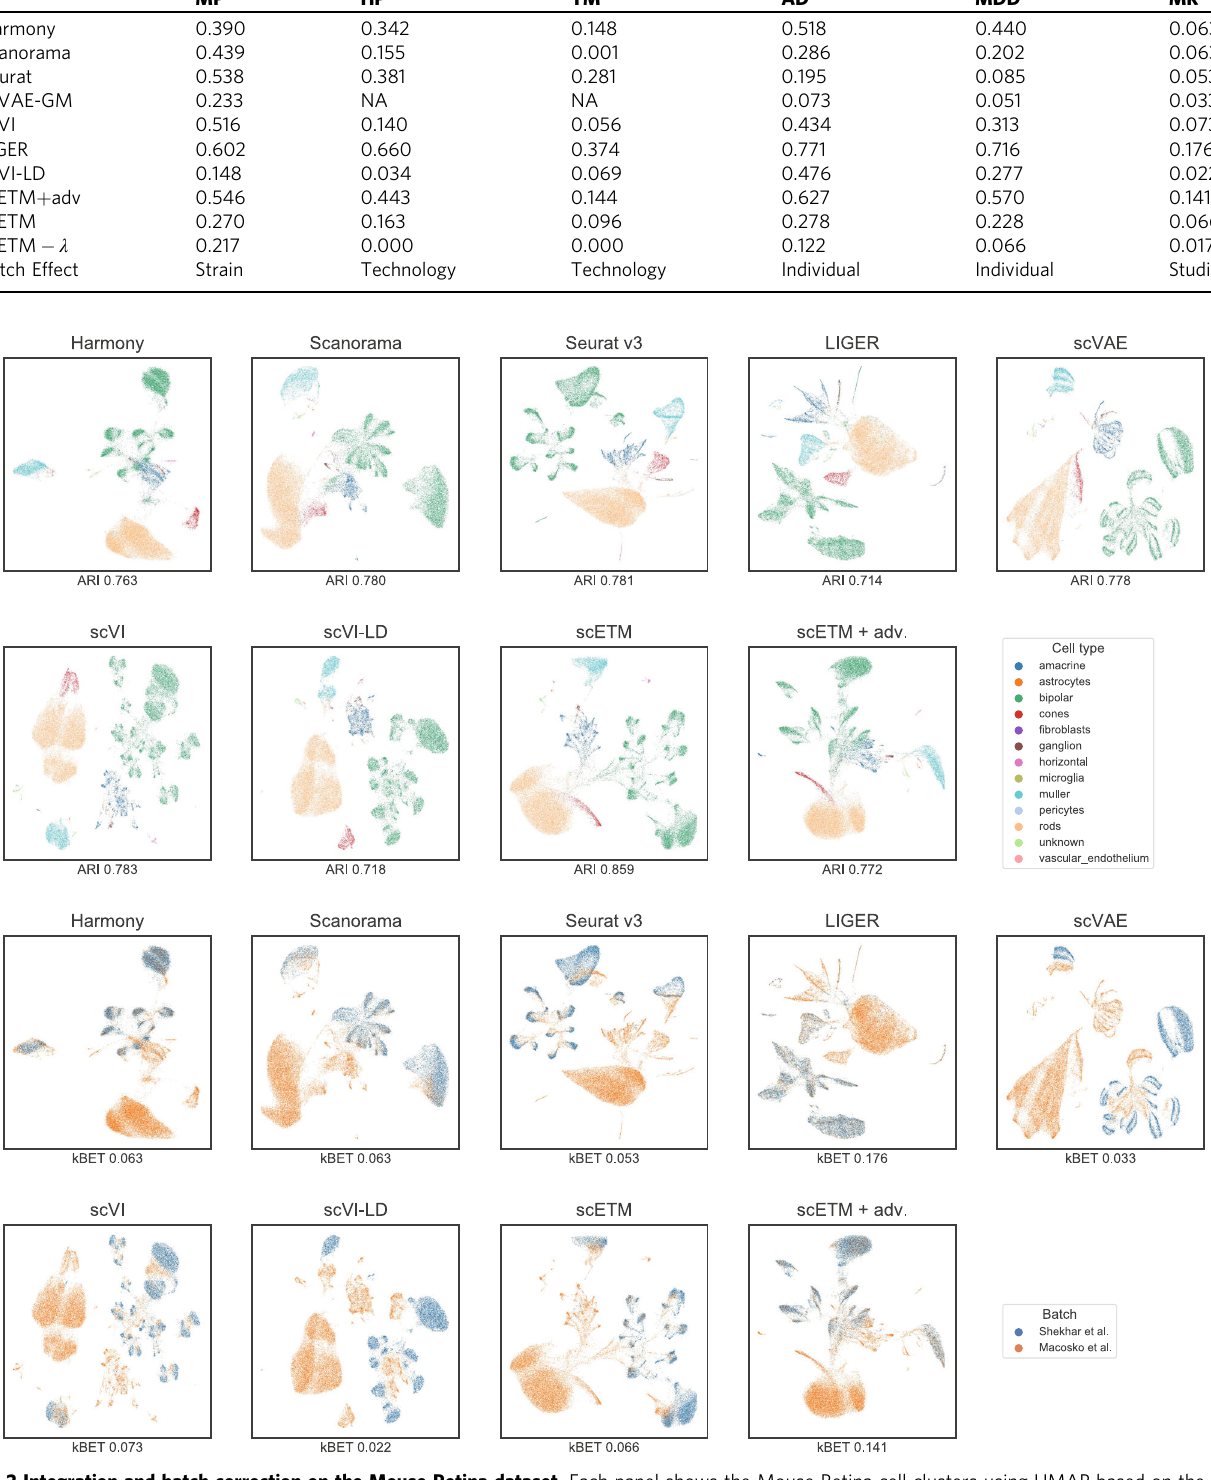
Fig. 2 Integration and batch correction on the Mouse Retina dataset. Each panel shows the Mouse Retina cell clusters using UMAP based on the cell embeddings obtained by each of the 9 methods. The cells are colored by cell types in the fi rst two rows and by batches, which are the two source studies, in the last two rows. The ARI and kBET scores of each method are shown below each plot. UMAP visualization for the other 5 datasets are illustrated in Supplementary Figs. 3, 4, 5, 6,